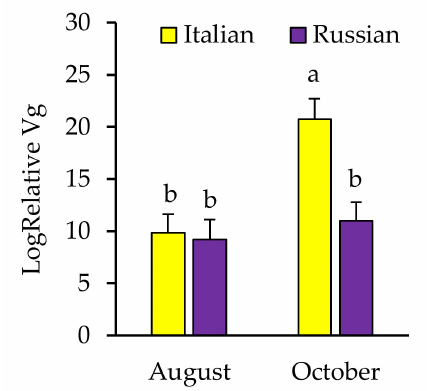
Figure 5. Relative amount (mean ± SE) of Vg (the gene encoding for the yolk-precursor protein, vitellogenin) in newly emerged bees from Italian and Russian colonies in August and October 2016. Bars with the same letters are not significantly different ( p > 0.05).